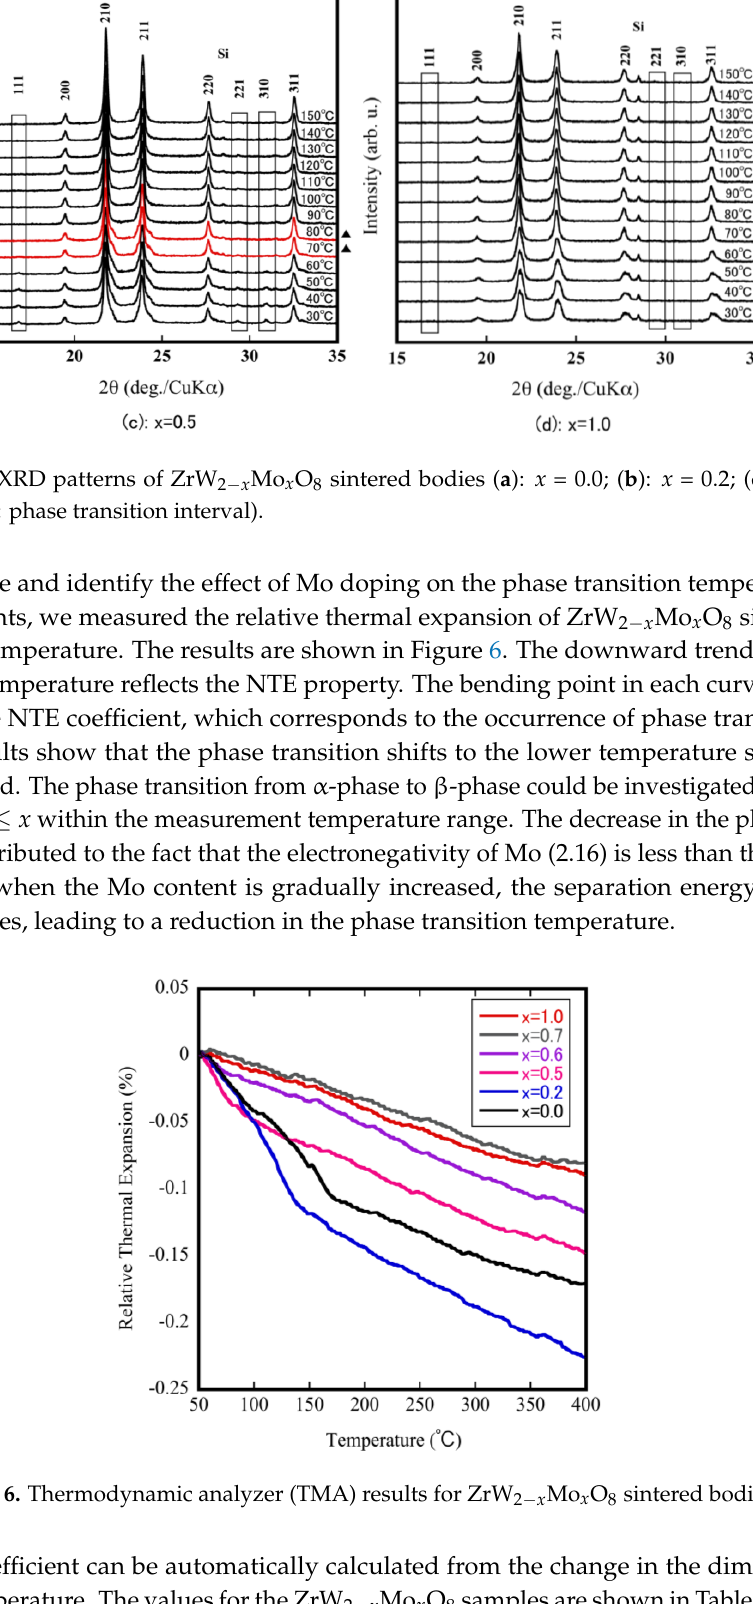
2 − x Mo x O 8 sintered